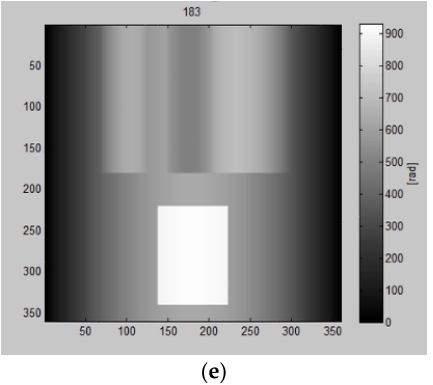
Figure 5. ( a ) Two different angular positions of rotation and simulated TIE phases; ( b ) Profiles corresponding to TIE phases; ( c ) application of IRT; ( d ) 3D reconstruction showing internal structure with different indices of refraction, and horizontal slice of internal structure; and ( e ) a screen capture of a 2D side view of the supplementary video showing the three cylinders and the cubic structure.